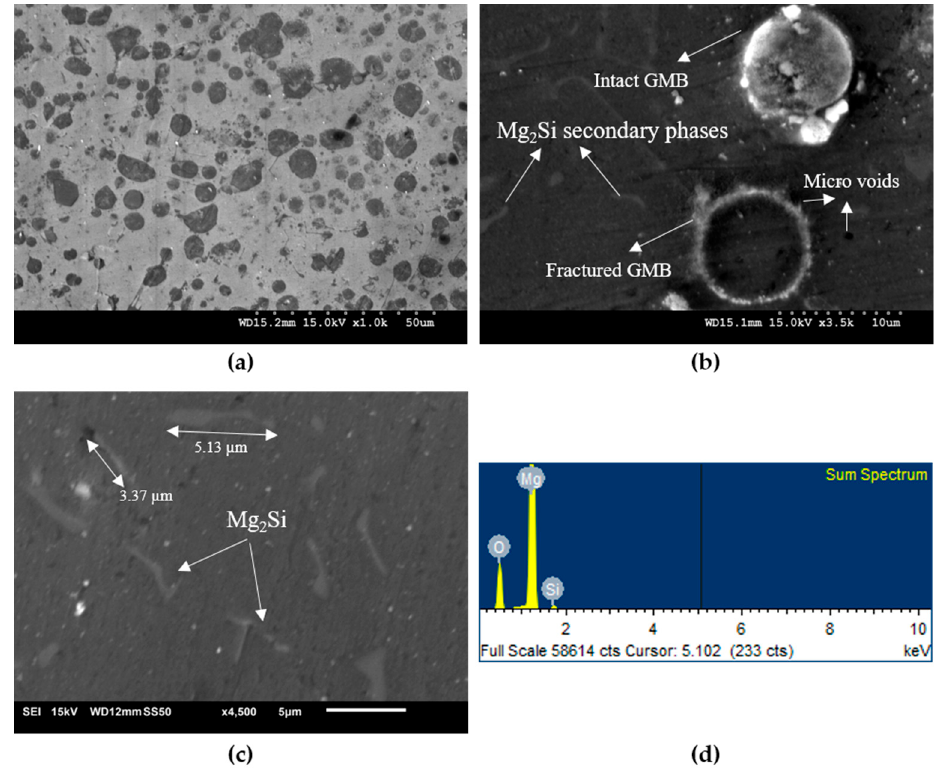
Figure 1. ( a ) Representative microstructure of Mg-15 foam; ( b ) GMB showing uniform wall thickness ( c ) Mg 2 Si dendrites present in the Mg matrix and ( d ) Energy dispersive spectrometer (EDS) result indicating the presence of Mg 2 Si as secondary phases.